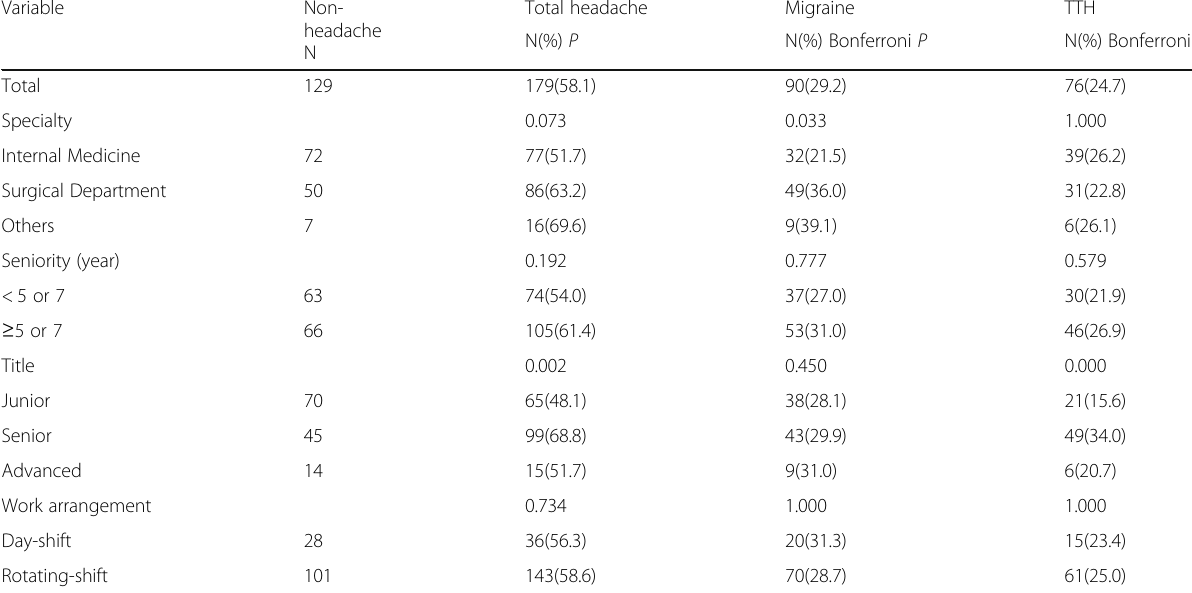
Table 4 The occupational characteristics comparisons between different types of headache and non-headache among nurses